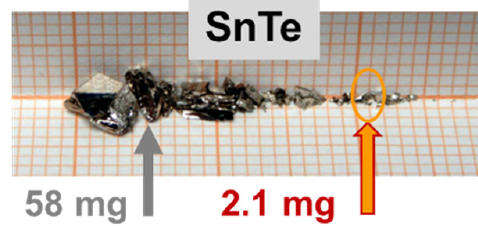
Figure 12. Selection of SnTe crystallites, leftovers from a several-cubic-centimeter large single crystal [45]. The arrows indicate two pieces used in this study: the larger for benchmarking of the temperature dependence of the magnetic susceptibility, the smaller for the validation of the in situ compensation